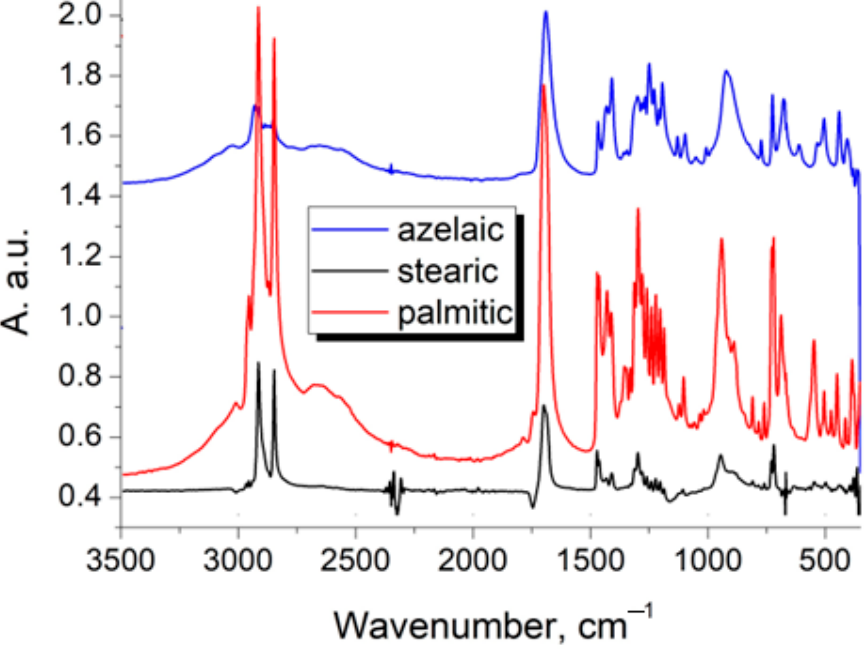
Figure 10. The FTIR spectra of fatty acids .